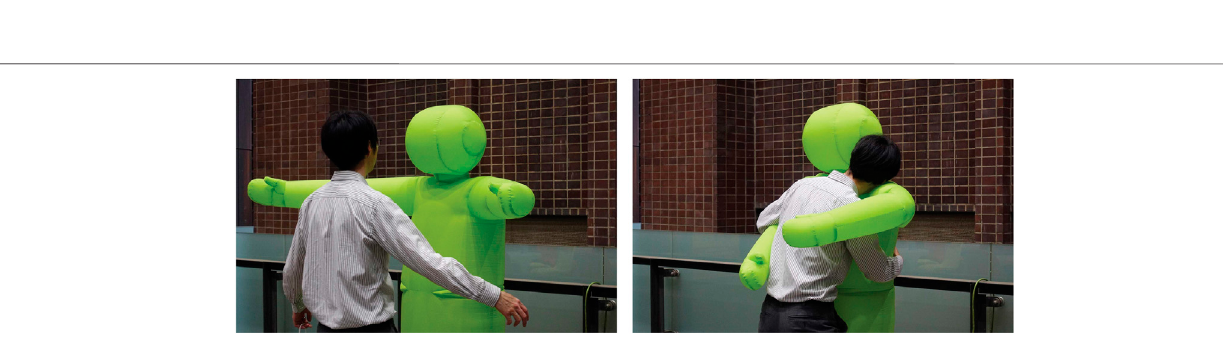
FIGURE 11 | In fl atable hug robot. (A) : de fl ated state, (B) : in fl ated state, (C) : tileted state with the trunk joint, (D) : hugging posture with bent shoulders and elbows, and (E) : Schematic diagram showing wire routing.